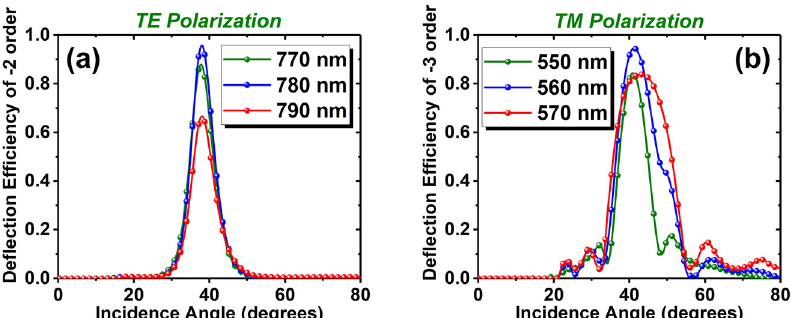
Figure 5: Narrow band pass spatial filtering achievable in the designed meta-array.